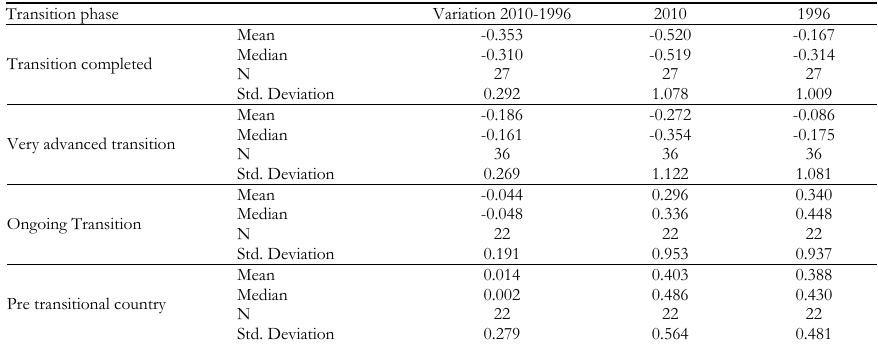
Mean and median scores for factor 2 by transition phase Transition